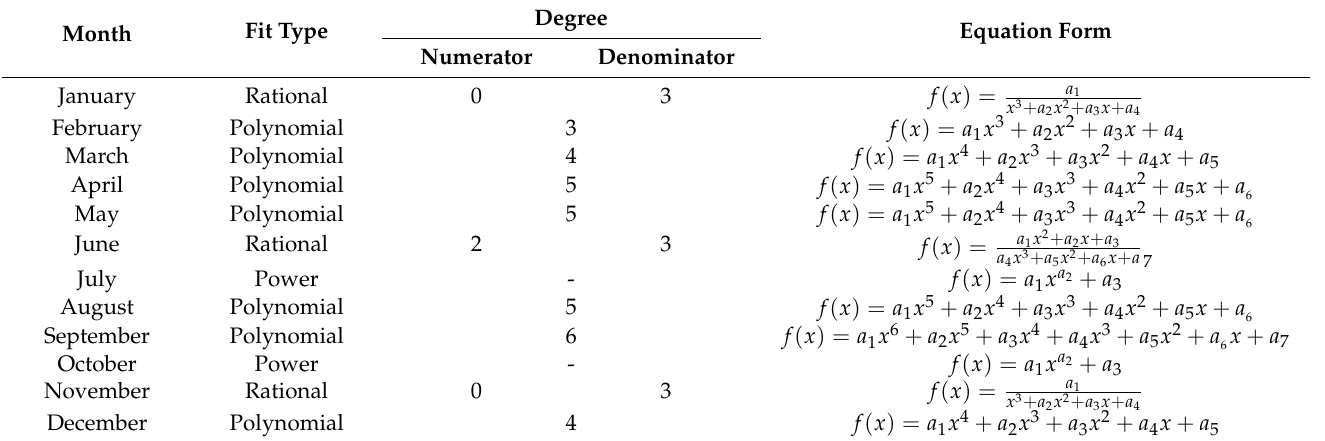
Figure A4. Monthly fitted FDC of Wulong section. Table A7. Fit type and equation form of Wulong section.